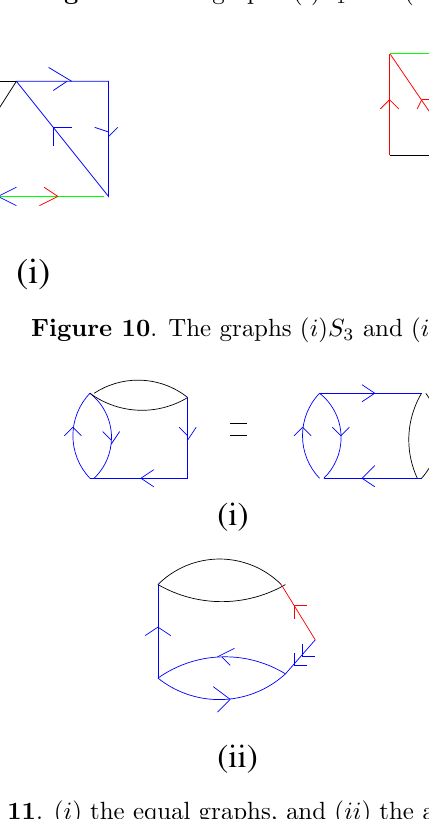
Figure 9 . The graphs ( i ) S 1 and ( ii ) S 2 .